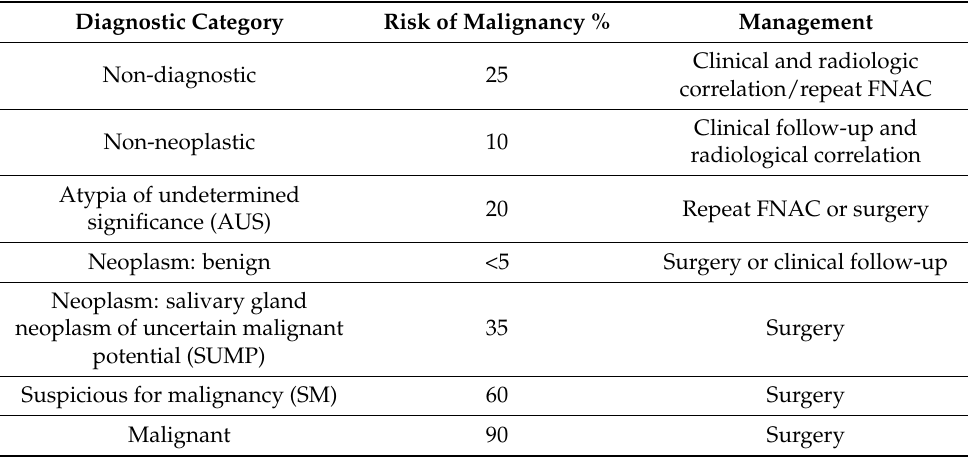
Table 2. Milan’s system of FNAB reporting for SGN